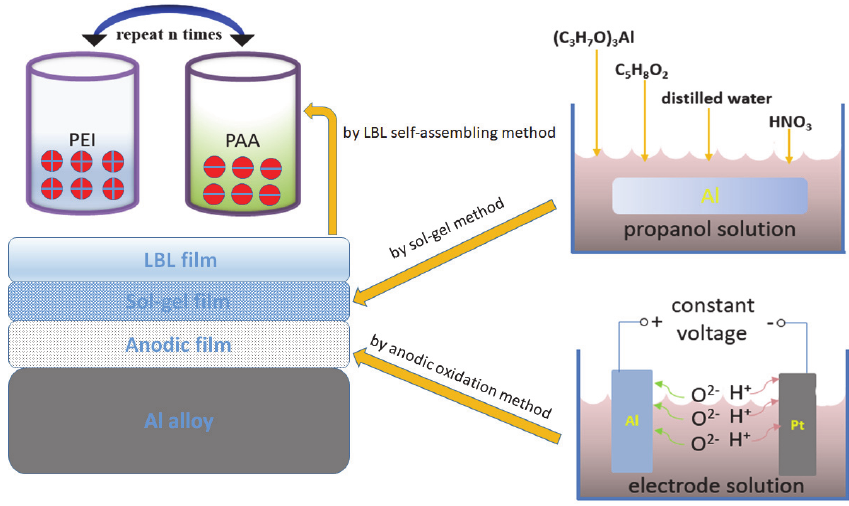
Figure 1. Schematic of the construction for protection film on Al alloy.